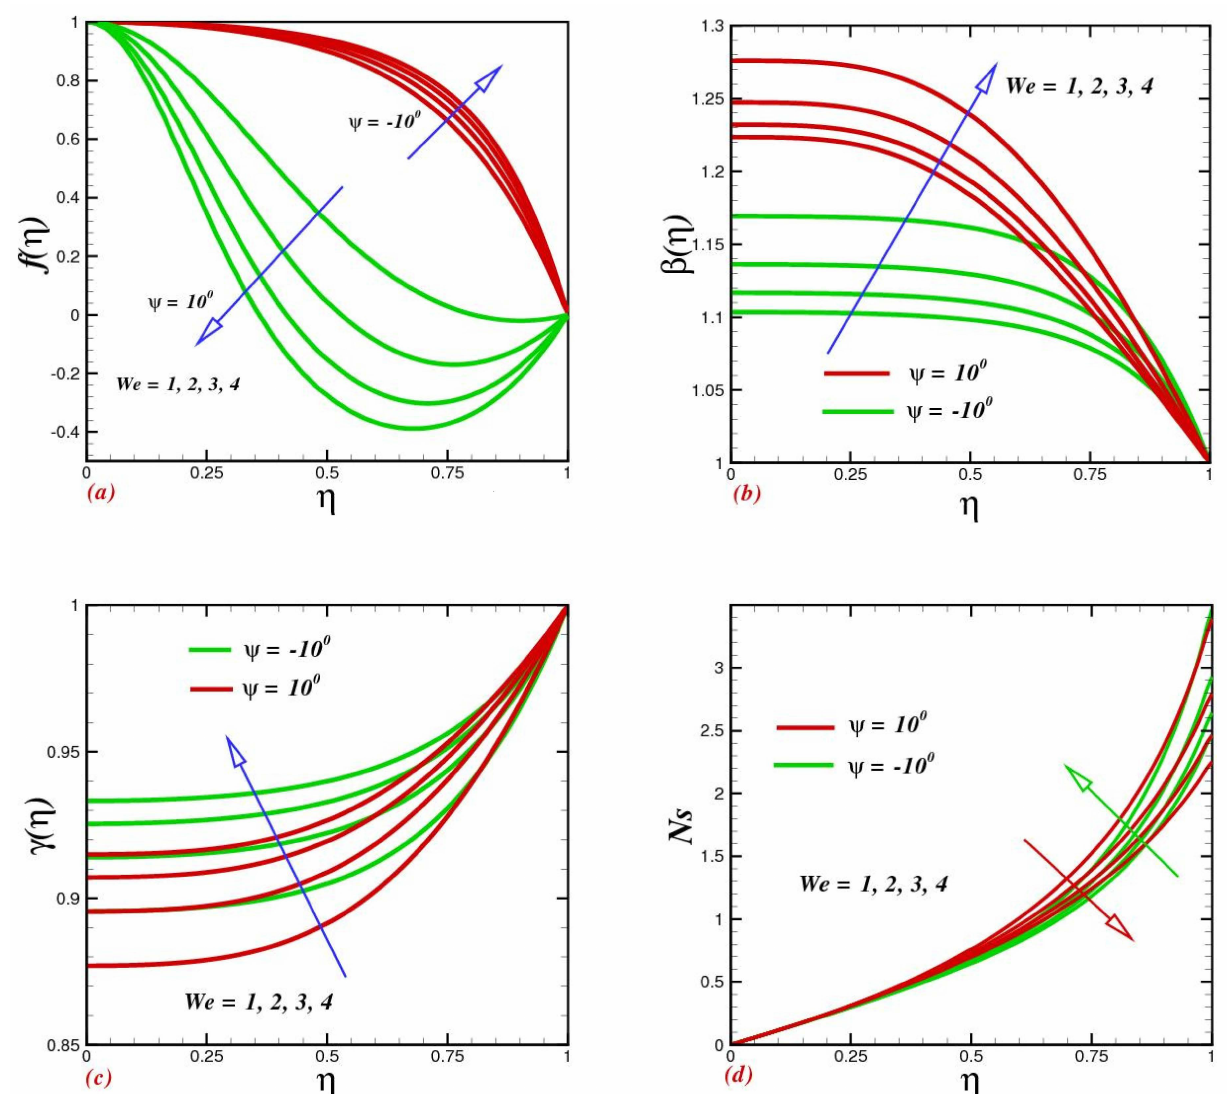
Figure 3. Impacts of the Weissenberg number We on ( a ) velocity f ( η ), ( b ) temperature β ( η ), ( c ) con- centration γ ( η ), and ( d ) entropy production Ns